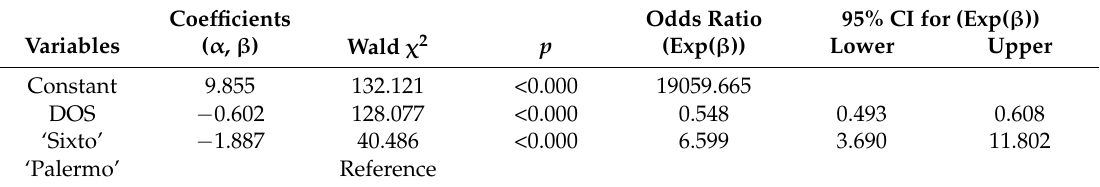
Table 5. Estimation of multiple logistic regression parameters for the “Italian sweet” red pepper cultivars (‘Sixto’ and ‘Palermo’) and number of days of storage (DOS) as factors influencing the probability of